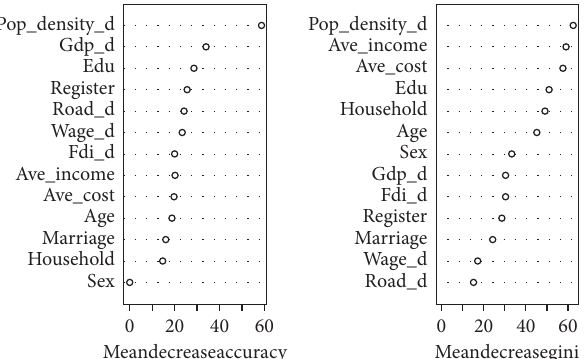
Figure 4: Factors in order of importance.